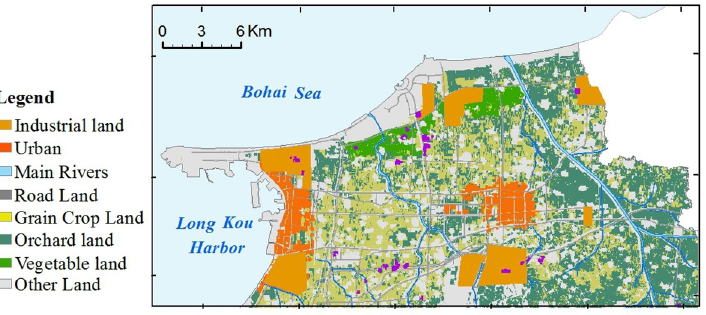
Fig 2. The maps of land use types in the study area. (The land used map was generated by interpreting free Landsat images).